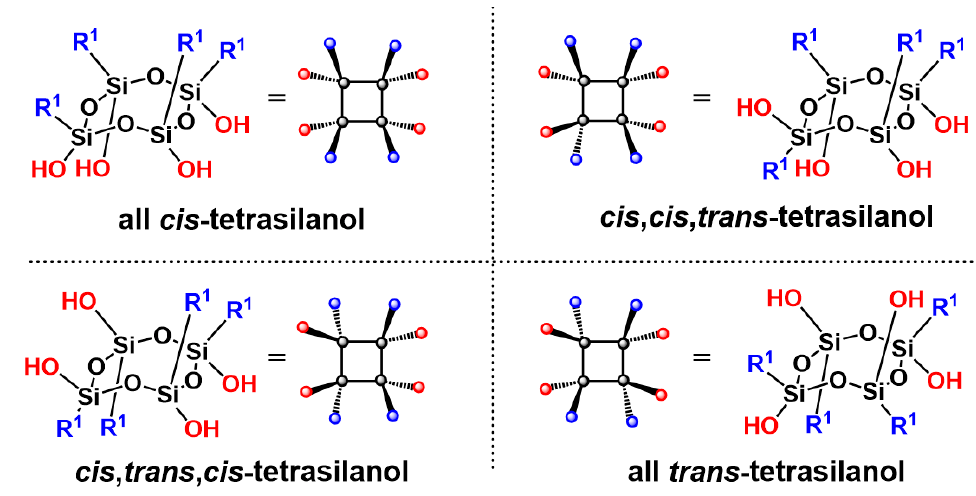
Figure 1. T 4 tetrasilanol